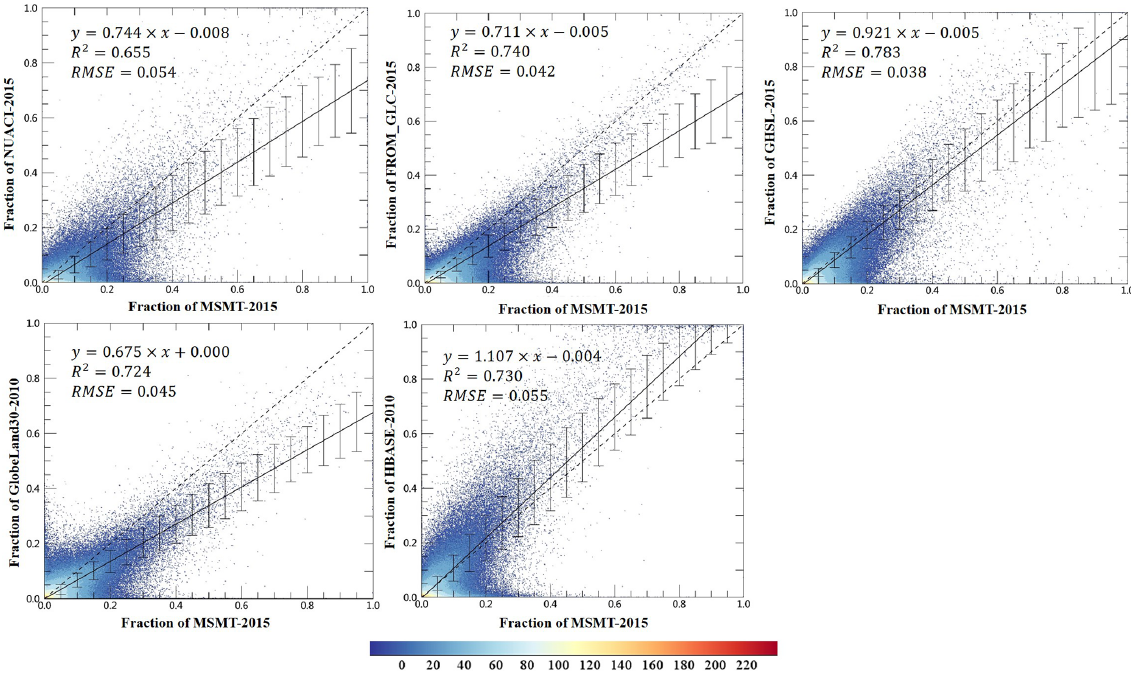
Figure 8. Scatterplots between the MSMT_RF-based impervious map and the GlobeLand30-2010, FROM-GLC-2015, NUACI-2015, GHSL-2015 and HBASE-2010 global impervious surface products at a spatial grid of 0 . 05 ◦ × 0 . 05 ◦ . The error bars are the standard de- viation between reference datasets with fitted